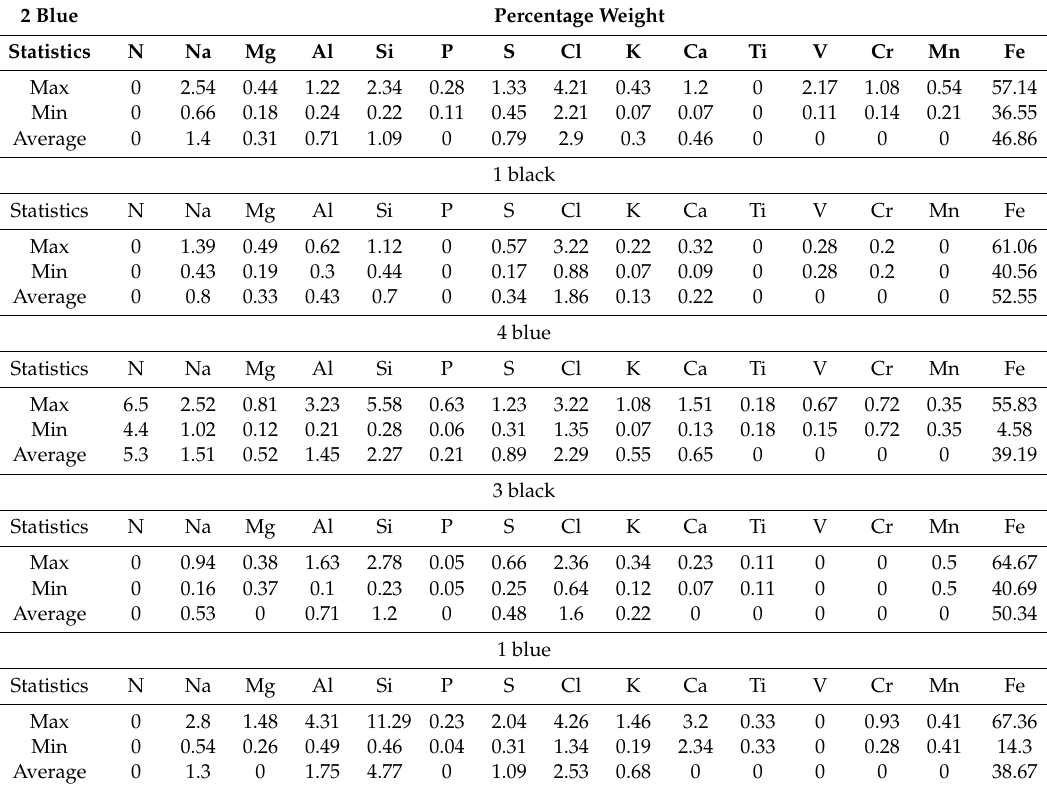
Table A2. Percentage weight from